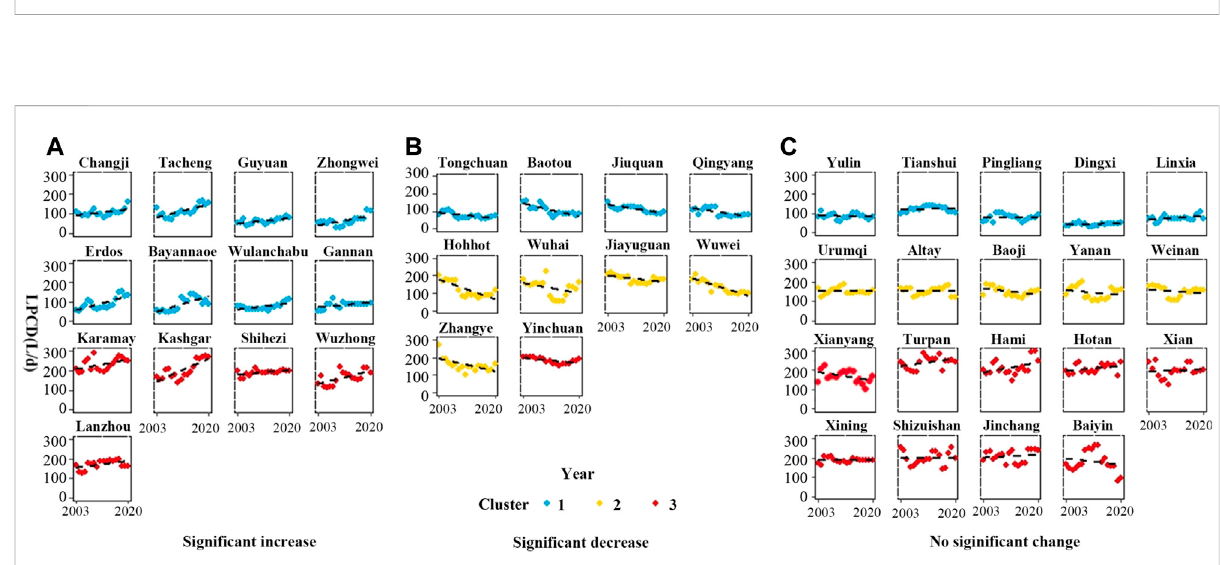
FIGURE 4 Spatial distribution of cities based on water consumption. Note: (A – C) represent the cities of clusters 1, 2, and 3, respectively. Value 1 and 0 in the map represents highest spatial aggregation (1) and none spatial agglomeration (0) of cities.